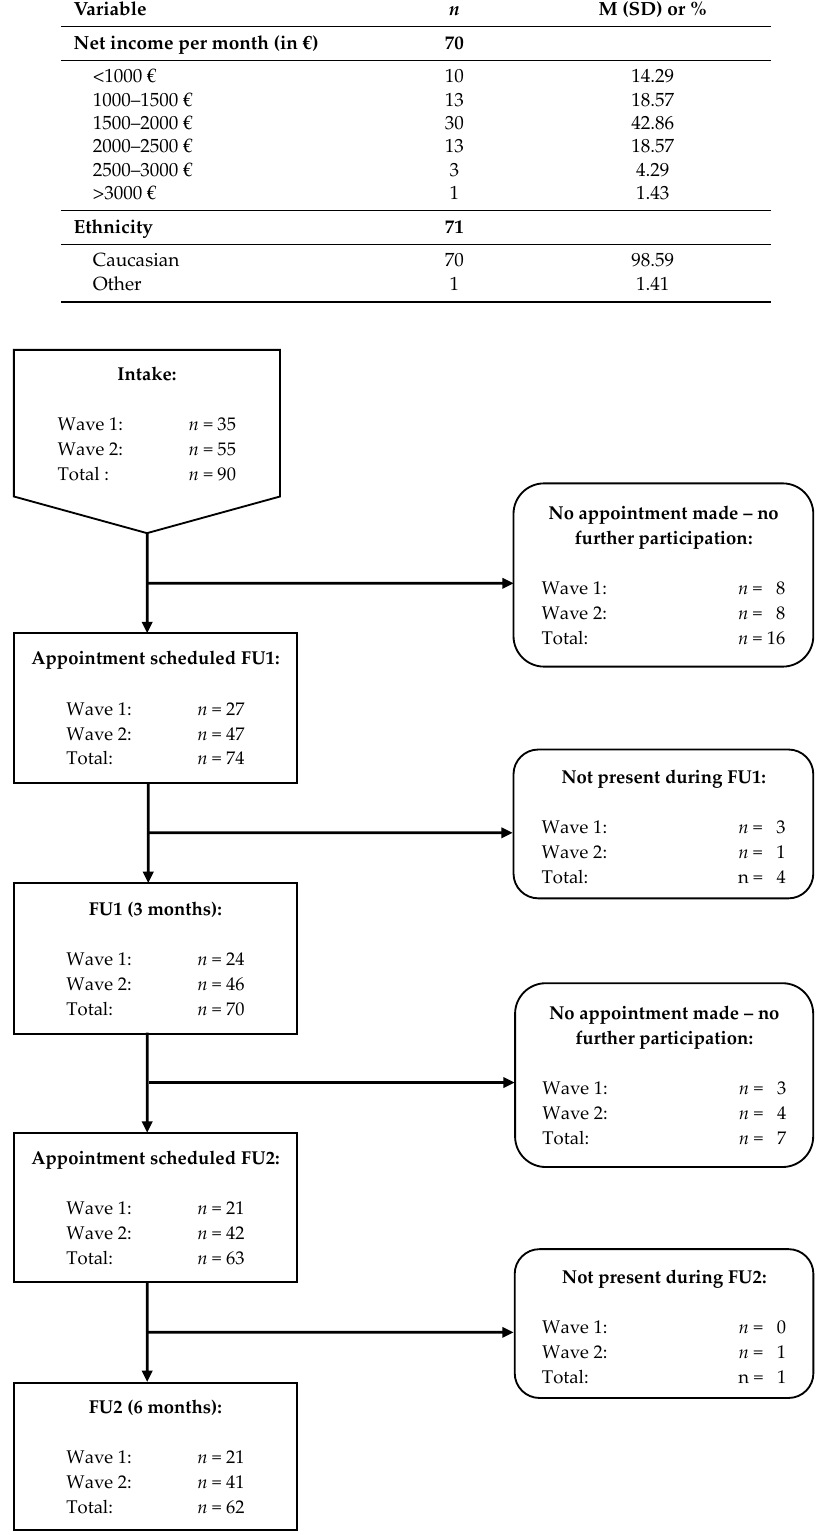
Figure 1. Participant flow; FU = Follow-Up